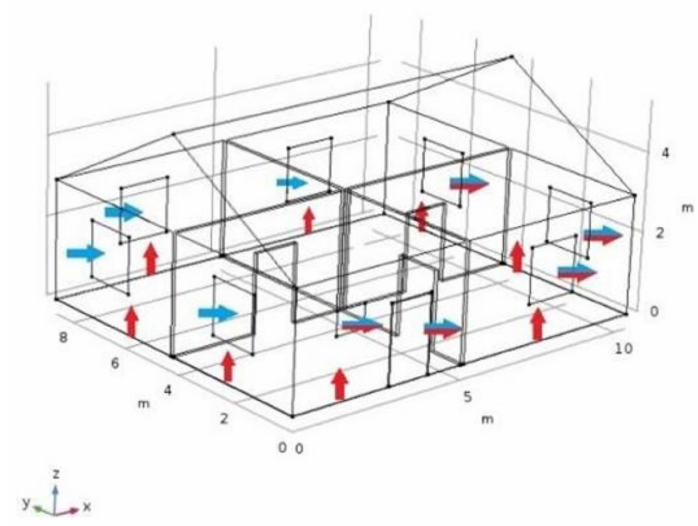
Figure 1. Geometry of the model. Schematic of the air streams and radon entry. (Legend: blue arrows—atmospheric air infiltrating the house due to the wind; red arrows—radon entry through the cracks; red and blue arrows—exiting streams on the leeward